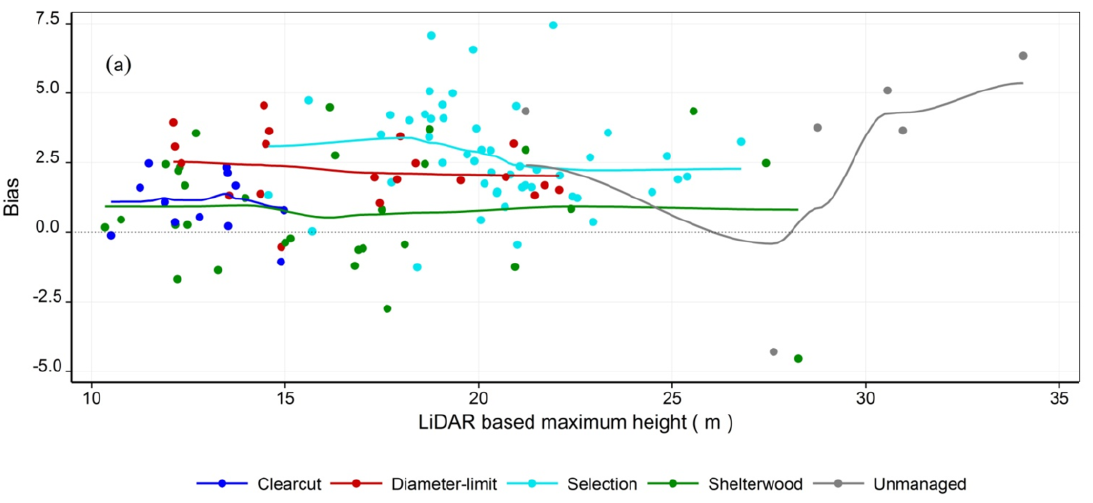
Figure 2. Scatterplot of maximum tree height prediction bias (observed-predicted; m) over LiDAR predicted values with Lowess regression splines for the different silvicultural treatments ( a ); and plot species composition based on basal area ( b